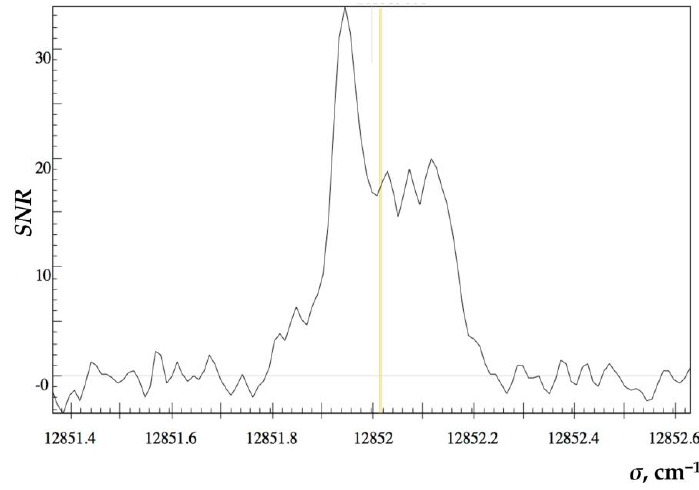
Figure 1. Profile of the Cu II line at 12852 cm −1 (7778.7 Å ) as measured in our Fourier transform spectrometers (FTS) spectrum. This line has a partially resolved hyperfine structure (HFS). The vertical line indicates the center of gravity.